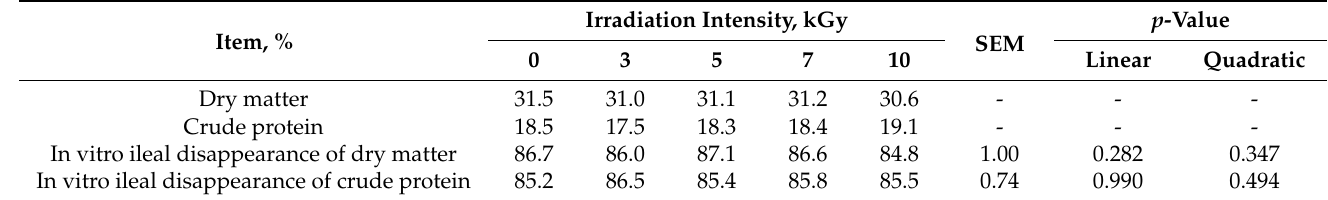
Table 7. Dry matter and crude protein concentrations in gamma-ray-irradiated chicken meat (as-is basis) and effects of irradiation condition on in vitro ileal disappearance of dry matter and crude protein of gamma-ray-irradiated chicken meat (Exp. 7) 1 .